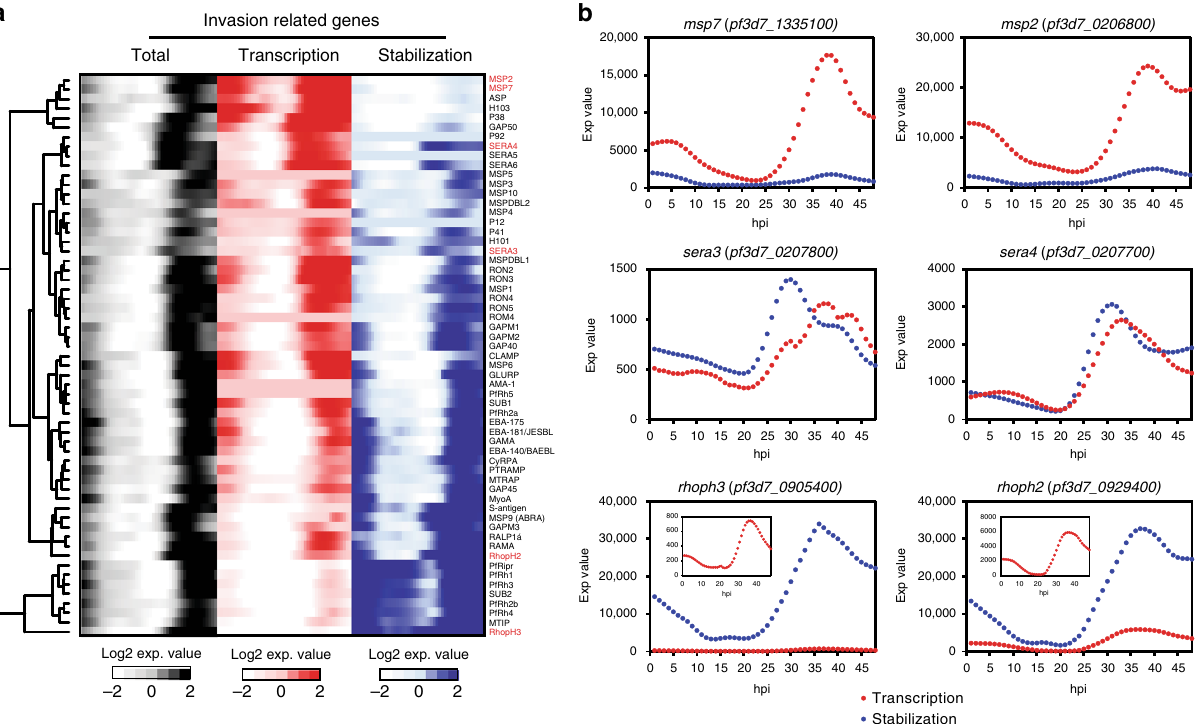
Fig. 5 mRNA dynamics of invasion-related genes. a The calculated total abundance (black), transcription (red), and stabilization (blue) expression values of selected genes demonstrated to be involved in parasite erythrocyte invasion are represented and clustered based on Euclidian distance metric. Highlighted in red text are selected genes representative of the various mRNA dynamics, which regulate expression. b The pro fi les of the expression of values of transcription (red circles) and stabilization (blue circles) for selected genes representing the dominant mode of regulation through nascent transcription ( msp7 and msp2 ), a balance of both transcription and stabilization ( sera3 and sera4 ), or stabilization alone ( rhoph3 and rhoph2 ) are plotted as throughout the IDC. The insets in rhoph2 and rhoph3 plots are the expression values of transcription from 0 to 48